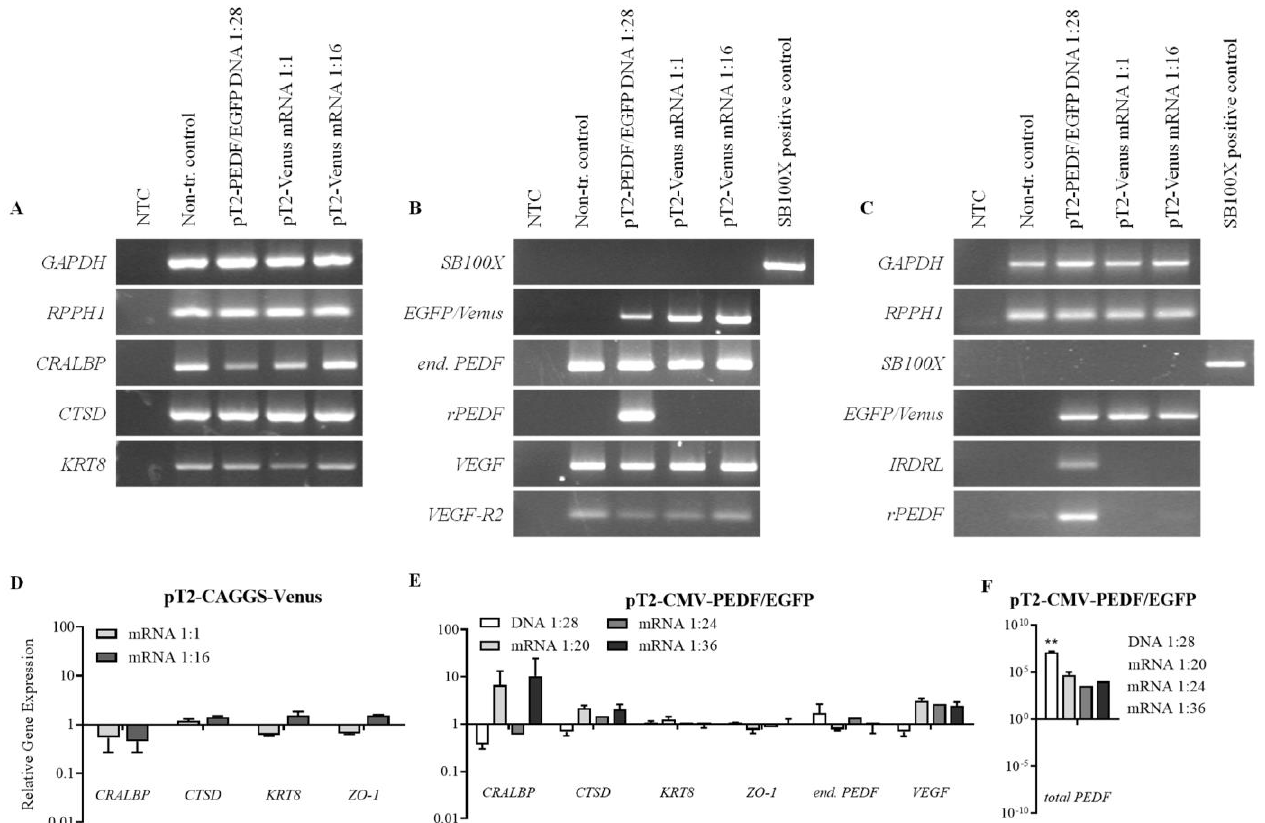
Figure 5. Gene expression and genomic analysis of ARPE-19 cells transfected with pT2-CAGGS-Venus or pT2-CMV-PEDF/EGFP compared with non-transfected control cells one year after transfection. One year after transfection, RNA and DNA were isolated from transfected and non-transfected ARPE-19 cell cultures, followed by PCR and agarose-gel electrophoresis ( A – C ) or real-time RT-qPCR ( D – F ). Panel A illustrates the mRNA expression levels of several endogenous genes in transfected and non-transfected cells. Panel B shows the expression of transfection related as well as PEDF and VEGF expression. Panel C illustrates the genomic DNA analysis of various sequences involved in the transfection. ( D , E ) Relative gene expression of different endogenous genes was analyzed by RT-qPCR in pT2-CAGGS-Venus or pT2-CMV-PEDF/EGFP transfected cells compared with non-transfected cells. ( F ) In PEDF-transfected cells, the expression of total PEDF was also analyzed. Gene expression changes were calculated using the ∆∆ Ct method, GADPH was used as housekeeping gene, and the results were expressed relative to the control group (non-transfected cells). All bars show mean ± SD from the two technical replicates. NTC—no template control, Non-tr.